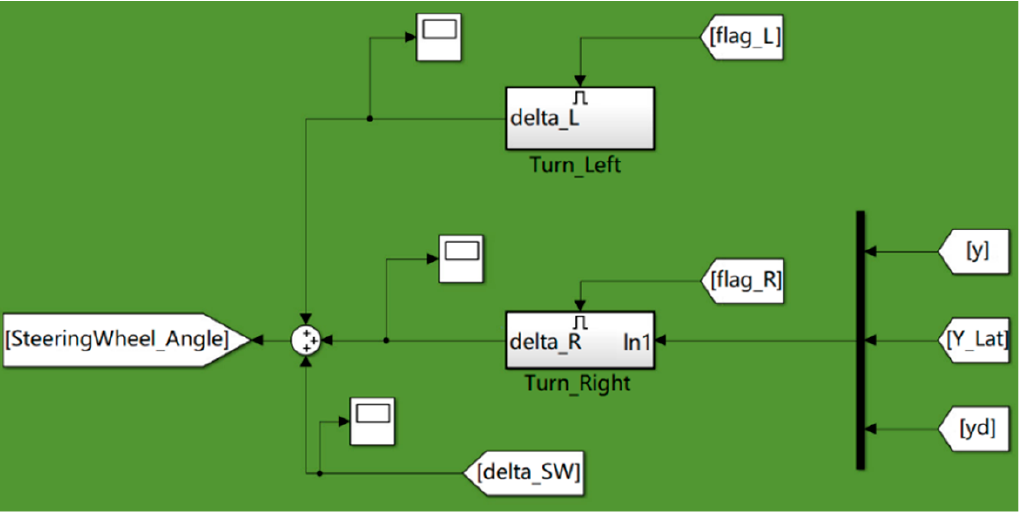
Figure 15. Steering Wheel Angle Control Module.